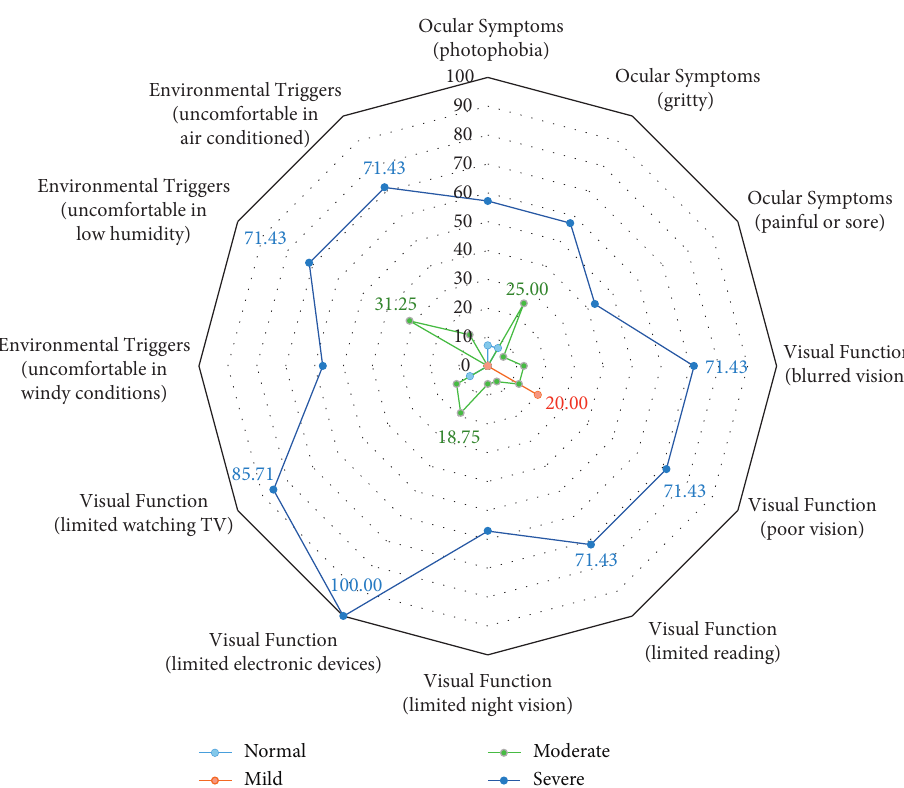
Figure 1: OSDI subscale scores in different subtype DED symptoms. The contributing factors of severe DED symptoms in hospitalized COVID-19 patients were visual function and environmental triggers. The contributing factors of moderate DED symptoms in hospitalized COVID-19 patients were environmental triggers (uncomfortable in low humidity), ocular symptoms (gritty), and visual function (limited electronic devices). In mild DED symptoms group, the contributing factor was mainly focused on visual function (poor